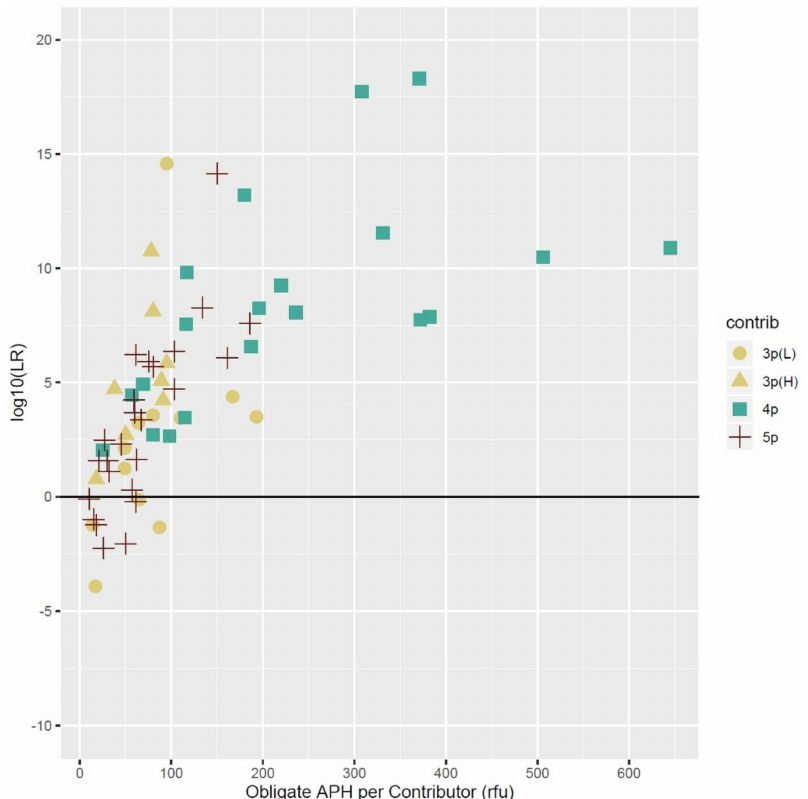
Figure 5. The log10 of the average LRs (N = 5) versus obligate average peak height (APH) for individual contributors that were present in low template amounts ( ≤ 100 pg). Each data point represents the obligate average peak height in RFUs representing all unshared alleles detected in a mixture for selected individual low-template contributors, regardless of mixture ratio. In total, 20–25 values each were selected for the three-, four-, and five-contributor mixtures that demonstrated the range of LRs observed in the